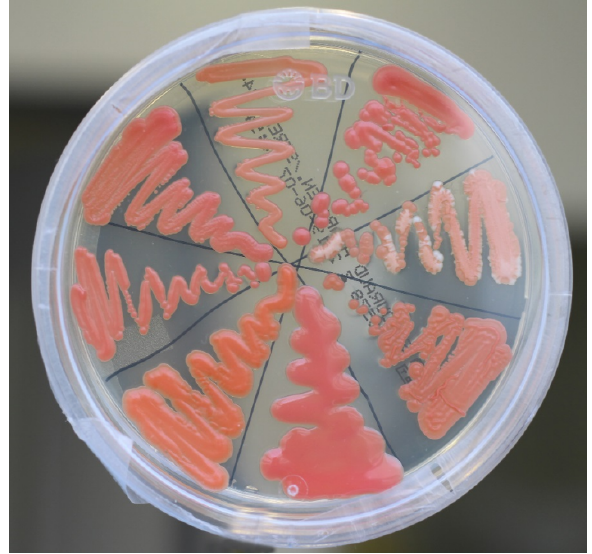
Figure 1: Appearancies of various colonies of Rhodotorula spp. on Sabouraud agar. 5 days after incubation at 30°C. Note the variable colour shades and